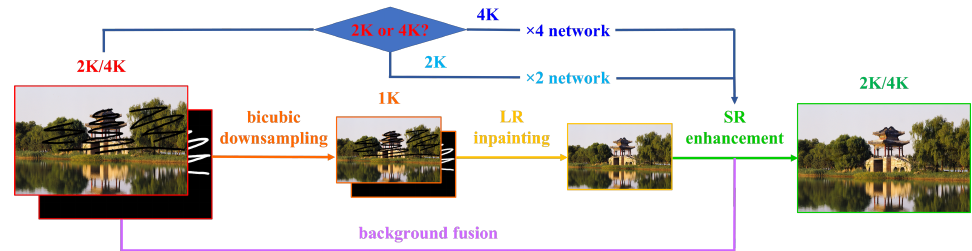
Figure 3. Implementation diagram of our high-resolution inpainting pipeline.